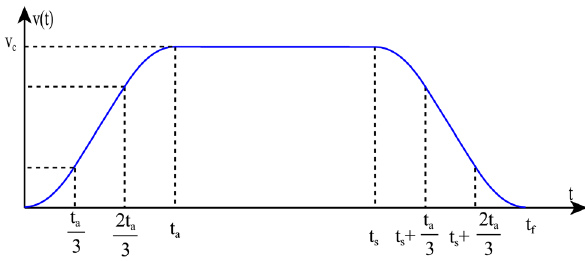
Figure 3: Diagram of trapezoidal velocity interpolation with para - bolic